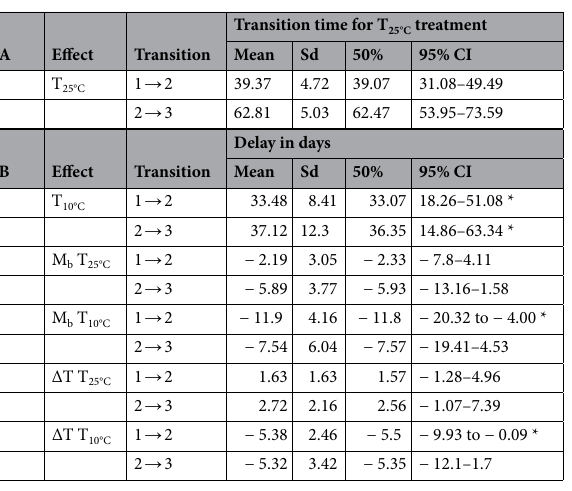
Table 3. Parameter estimates for seasonal sexual maturation rate. (A) Transition time between sexual maturation classes for bats from the T 25°C treatment (in days since capture). (B) Effects of T 10°C and M b and ΔT within each treatment expressed as delay in transition between seasonal sexual maturation classes. Posterior distributions are presented by their mean, standard deviation and by the 2.5th, 50th and 97.5th percentiles. Significant effects (i.e., 95% credible interval does not overlap 0) are marked with asterisks. Effects’ unit is in